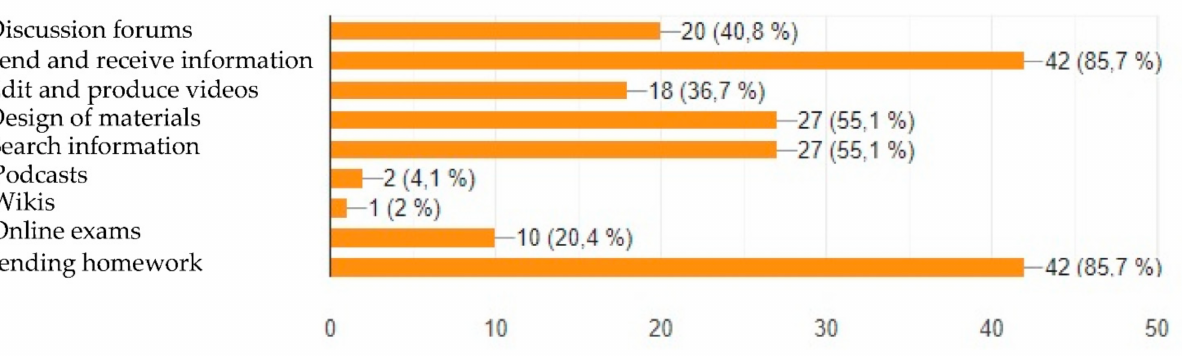
Figure 4. Uses of technology by